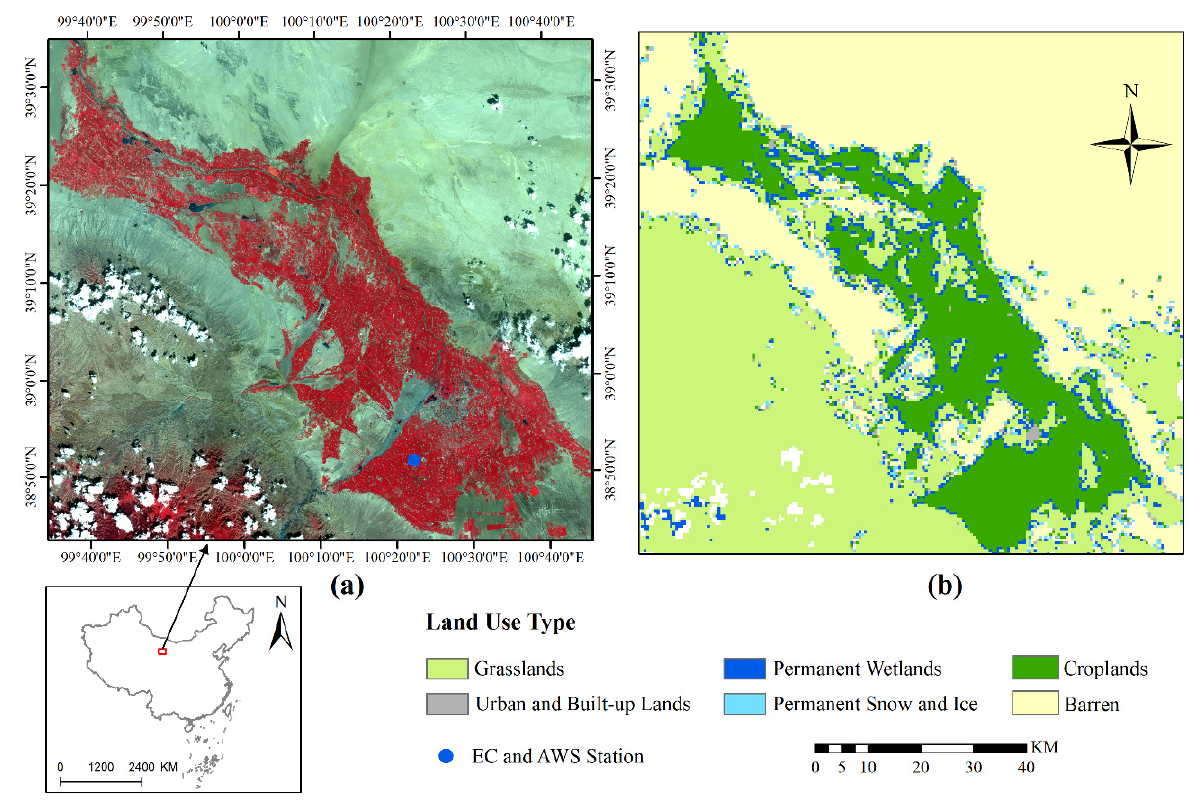
Figure 1. ( a ) The standard false-color composite image for the oasis–desert area from the GF1 WFV3 sensor in 2016; ( b ) the land-use type from MCD12Q1 IGBP class